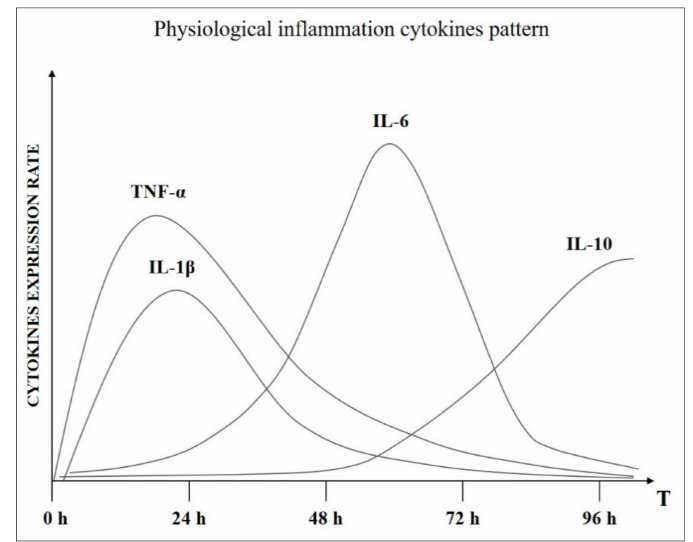
Figure 1. Cytokines chronobiological pattern in normal inflammatory